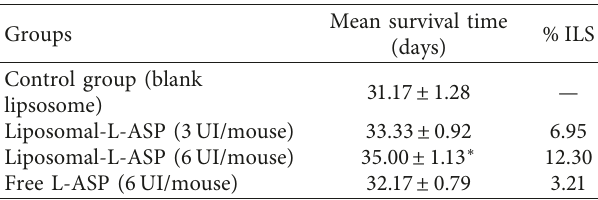
∗ P < 0 . 05 in comparison with the control group (blank